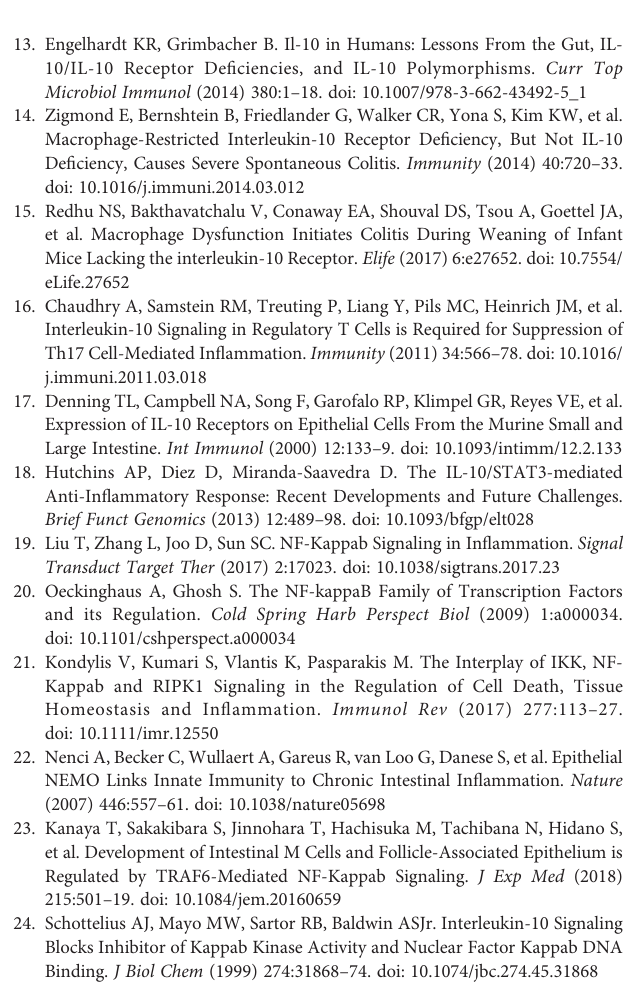
Supplementary Figure 3 | Proportion of genes identi fi ed as NFkB target genes from TNF-stimulated enteroid RNA sequencing. Supplementary Figure 4 | qPCR analysis of early response NFkB regulated genes in C57BL/6J enteroids. Supplementary Figure 5 | Resting levels of NFkB target genes in enteroids de fi cient in interleukin 10. Supplementary Figure 6 | NFkB target genes encoding ABIN1 and ABIN2 are overexpressed in interleukin 10 de fi cient